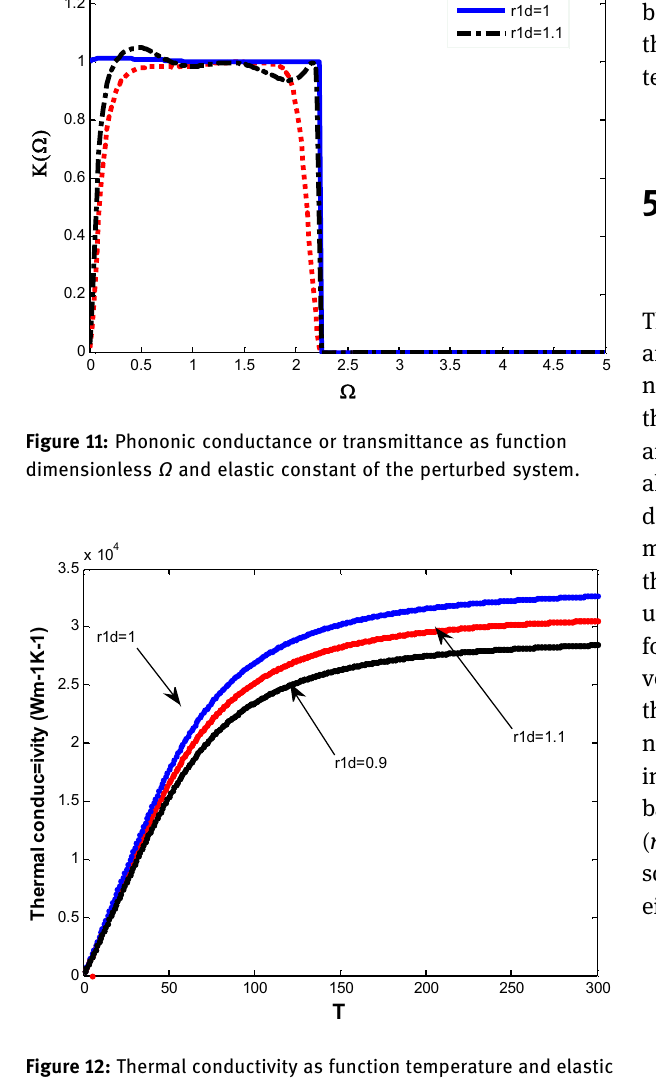
Figure 12: Thermal conductivity as function temperature and elastic constants near the defect.